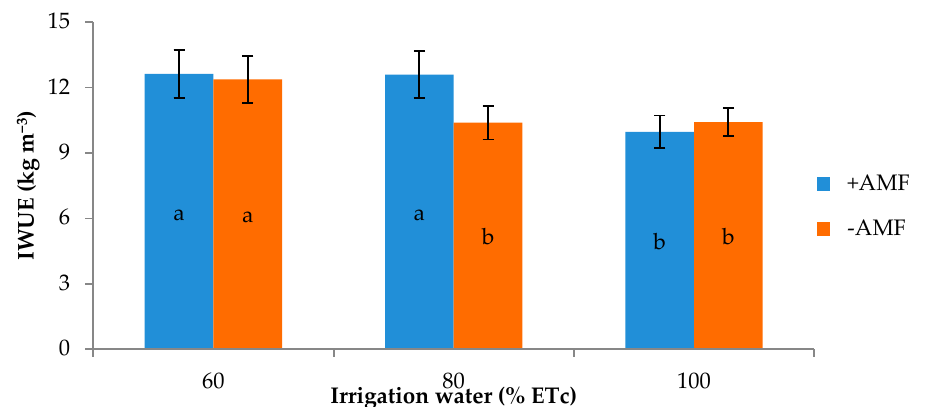
Figure 7. Effect of irrigation treatments and plant inoculation with arbuscular mycorrhizal fungi (AMF) on irrigation water use efficiency (IWUE) of melon plants during two years of experiments (bars with different letters are significantly different at p < 0.05 according to the LSD test). The nitrogen applied efficiency (NAE) was conditioned by the irrigation treatment (Table 3, Figure 8), the highest value (248.4 kg kg − 3 N) being in the 100% ETc treatment. Water stress significantly reduced the NAE of non-mycorrhized plants grown under moderate ( − 17.2%) or intense ( − 24.5%) stress, and of mycorrhized plants grown under intense stress ( − 22.8%). The mycorrhized plants reacted better to moderate water stress maintaining an NAE value not significantly different from the well-watered treatments (251.1 kg kg − 3 N).